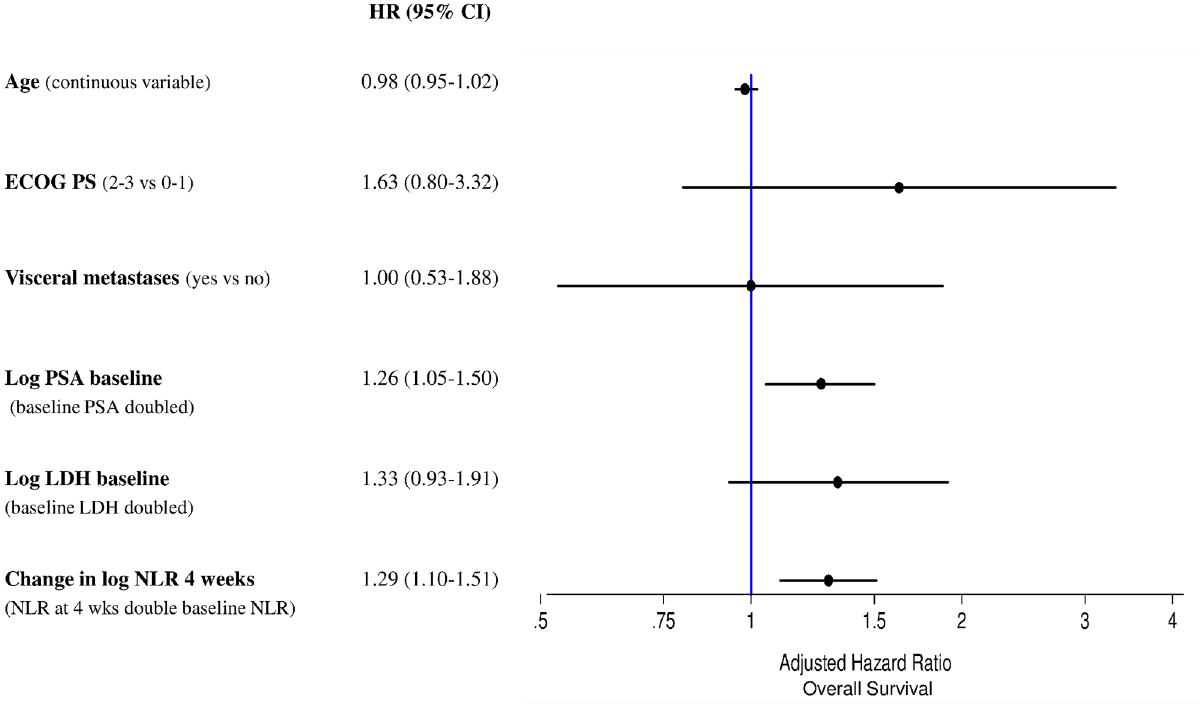
Fig 2. Forest plot for overall survival.